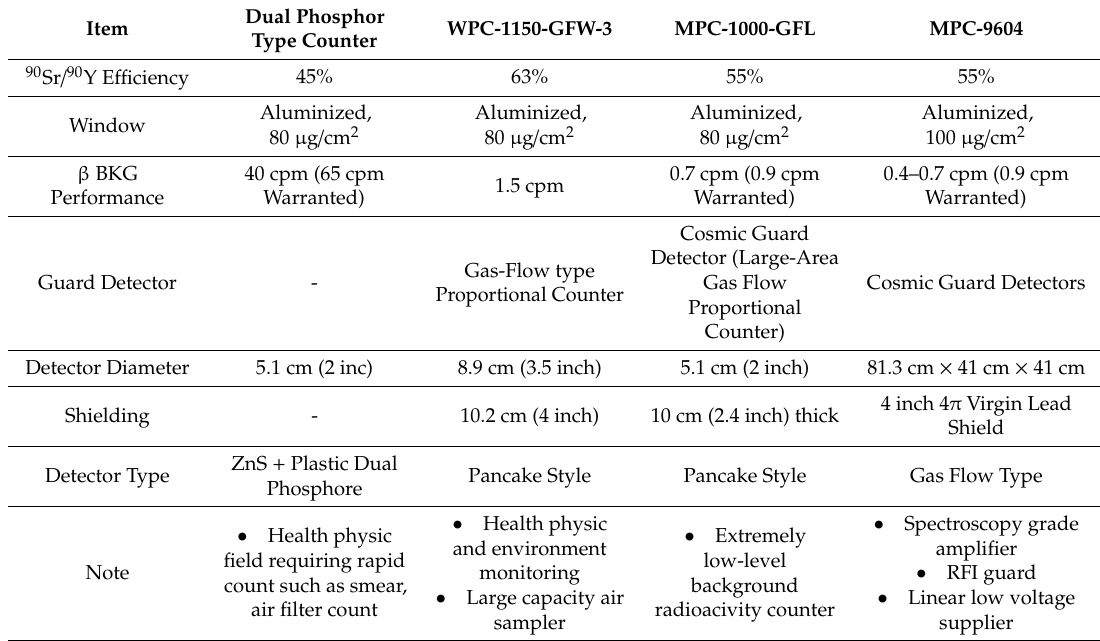
Table 17. Dual phosphor type and gas-flow type proportional